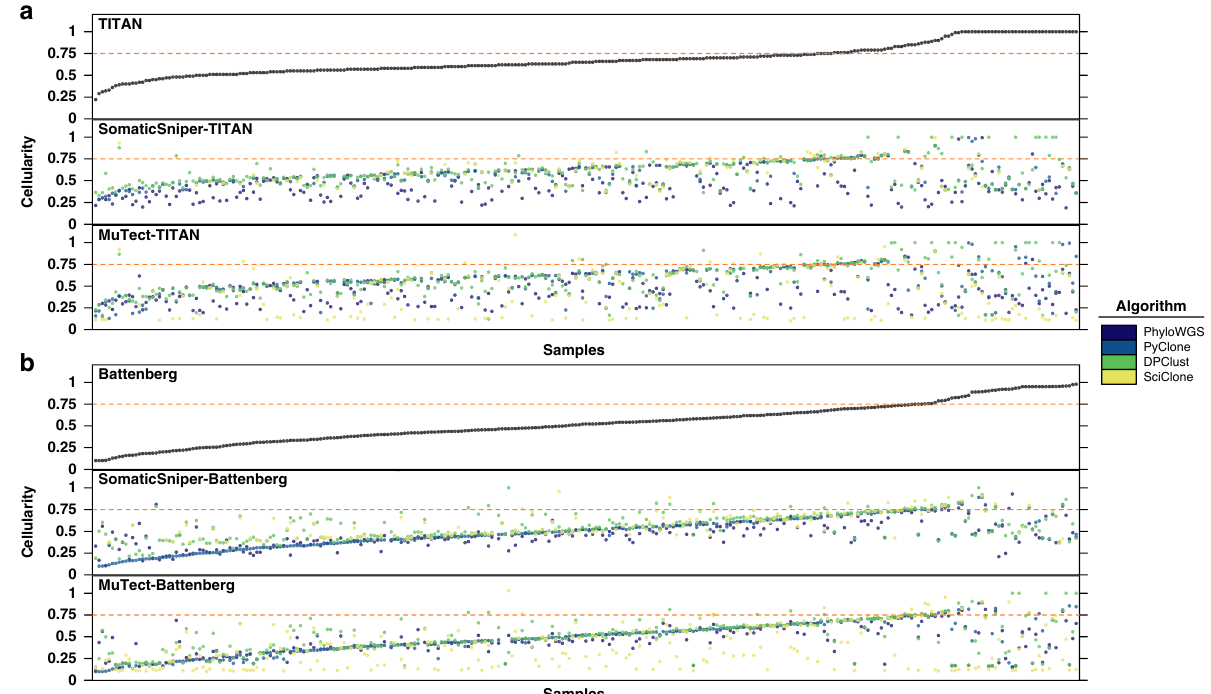
Fig. 2 CNA detection tools in fl uence pipeline cellularity estimates. Cellularity of samples as estimated by the CNA detection tool and by subclonal reconstruction pipelines using the CNA detection tool a TITAN and b Battenberg. Each dot represents the estimate for a sample and colors delineate subclonal reconstruction algorithms. Mutation detection tool combinations using Battenberg include SomaticSniper-Battenberg and MuTect-Battenberg, and mutation detection tool combinations using TITAN include SomaticSniper-TITAN and MuTect-TITAN. Samples are ordered by cellularity estimates by the CNA detection tool. The horizontal line indicates cellularity 0.75. CNA, copy number aberration. TITAN: n = 293 biologically independent